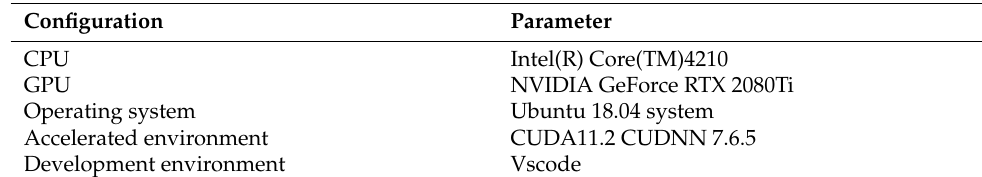
Table 2. Experimental hardware environment.